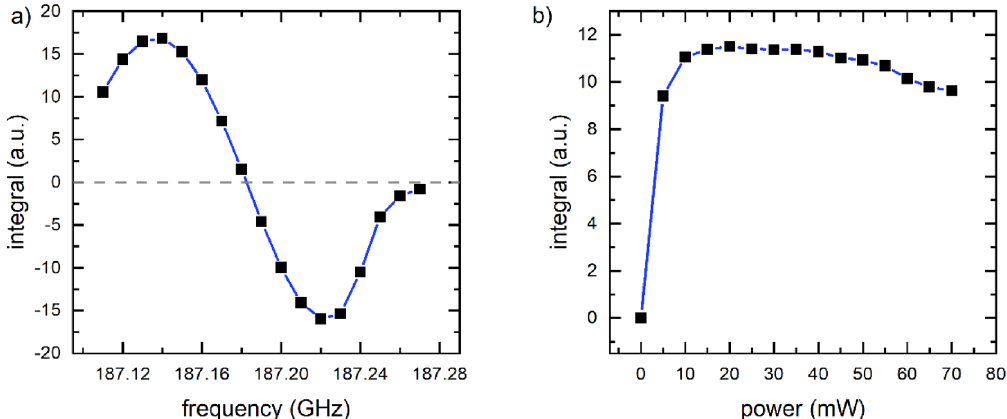
Figure 4. Optimization of 13 C polarization transfer. DNP-enhanced, solid state 13 C-NMR signal of pyruvate at ≈ 1.4 K as a function of microwave frequency (a, p MW w = 30 mW) and microwave power (b, ν MF ≈ 187.135 GHz). When the frequency was varied (a), two extrema were observed, and the first maximum at ≈ 187.135 GHz was chosen for later experiments. For the power sweep, the signal was found to increase up to 20 mW; 16 mW was used in the subsequent experiments. Straight lines were added to guide the eye. 13 C polarization was destroyed after each signal acquisition. Each data point corresponds to the 13 C-signals acquired after 2 min of DNP. NMR acquisition parameters were p RF w = 2 µs, p RF a = 3 dB, NS = 4, and α ≈